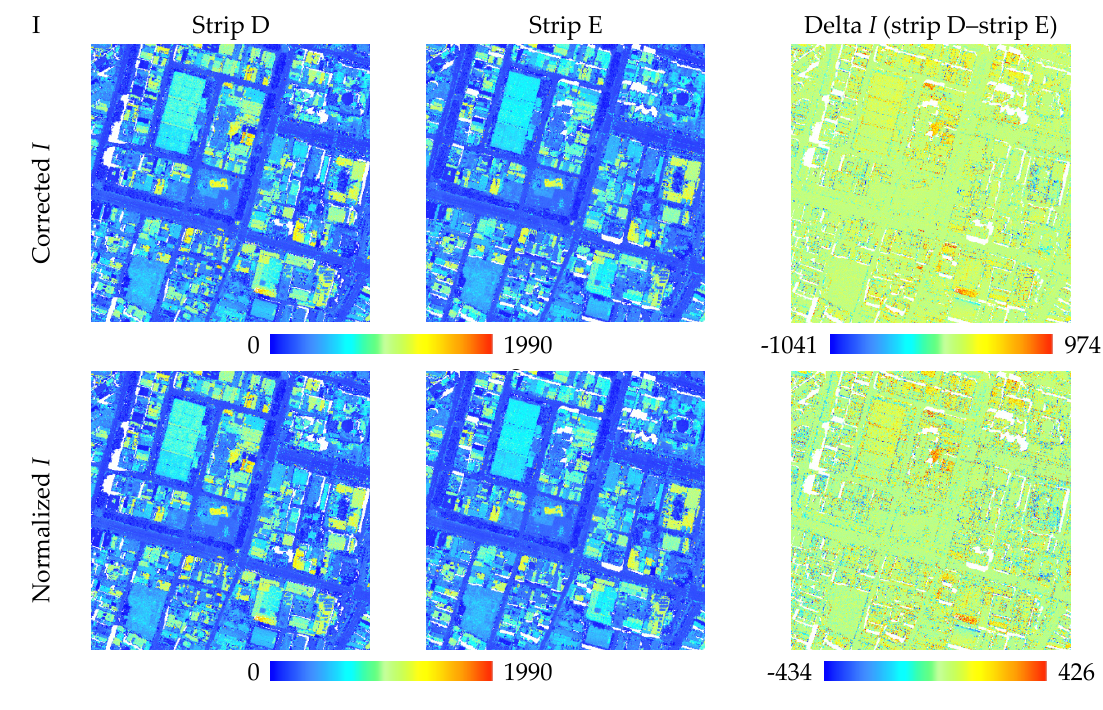
Figure 10. Delta intensity in overlapped area.